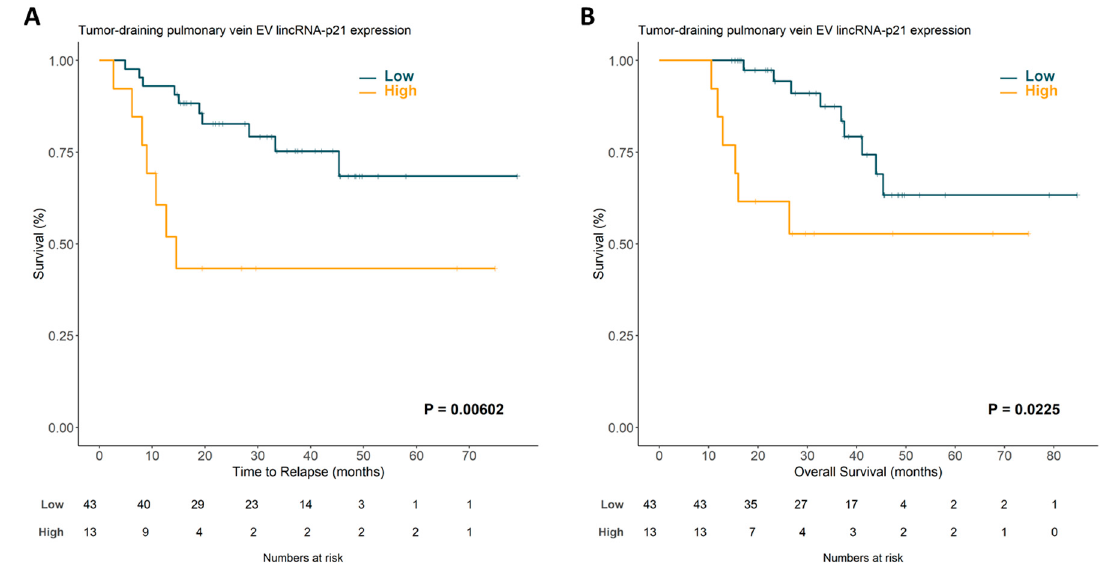
Figure 1. Time to relapse ( A ) and overall survival ( B ) according to lincRNA ‐ p21 expression in tumor ‐ draining pulmonary vein exosomal samples from non ‐ small cell lung cancer (NSCLC) patients. EV, extracellular vesicle.